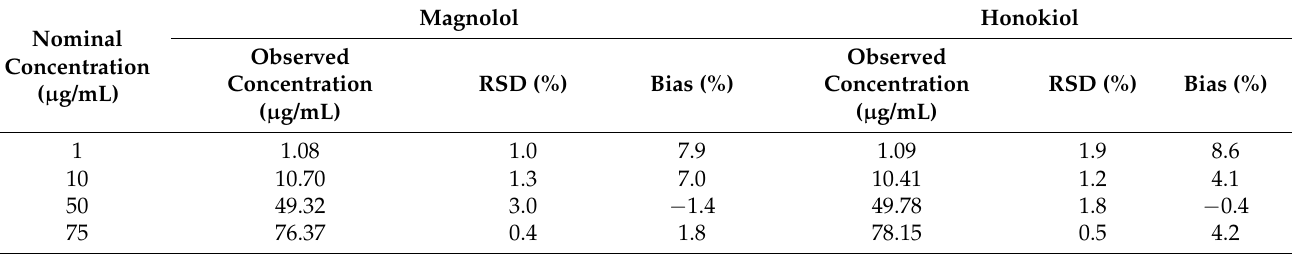
Table 1. Precision and accuracy for the determination of magnolol and honokiol (n = 4).